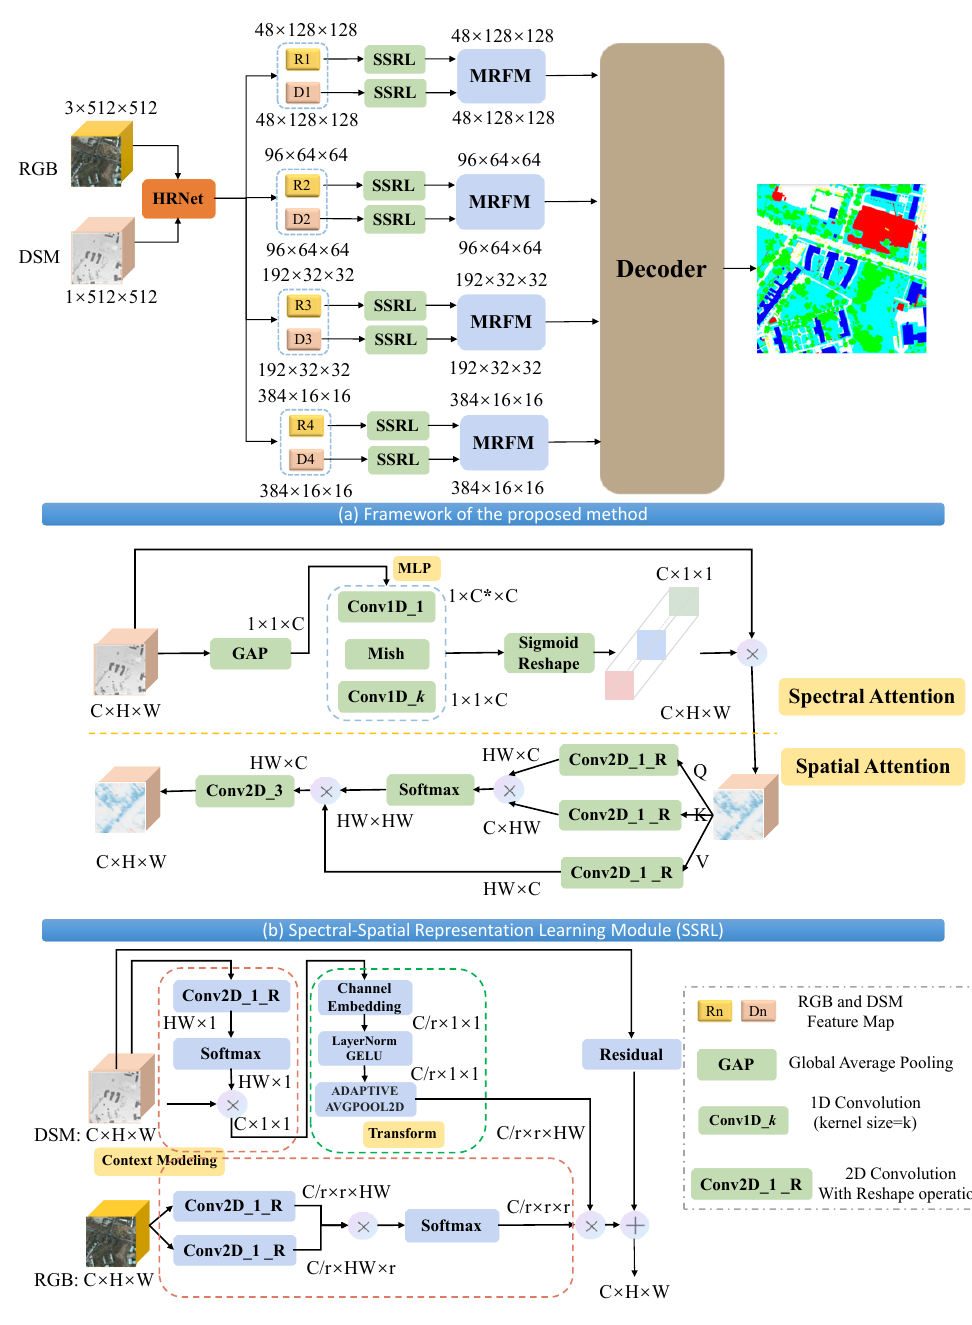
Figure 2. ( a ) Illustration of the proposed framework for LCC in foggy conditions. The input consists of a pair of the optical image and DSM. UperHead is selected as the decoder. ( b ) Detailed design of SSRL, which is composed of Spectral Attention and Spatial Attention modules. C and C ∗ are different channel numbers. ( c ) The framework of MRFM is to explore the complementarity of heterogeneous